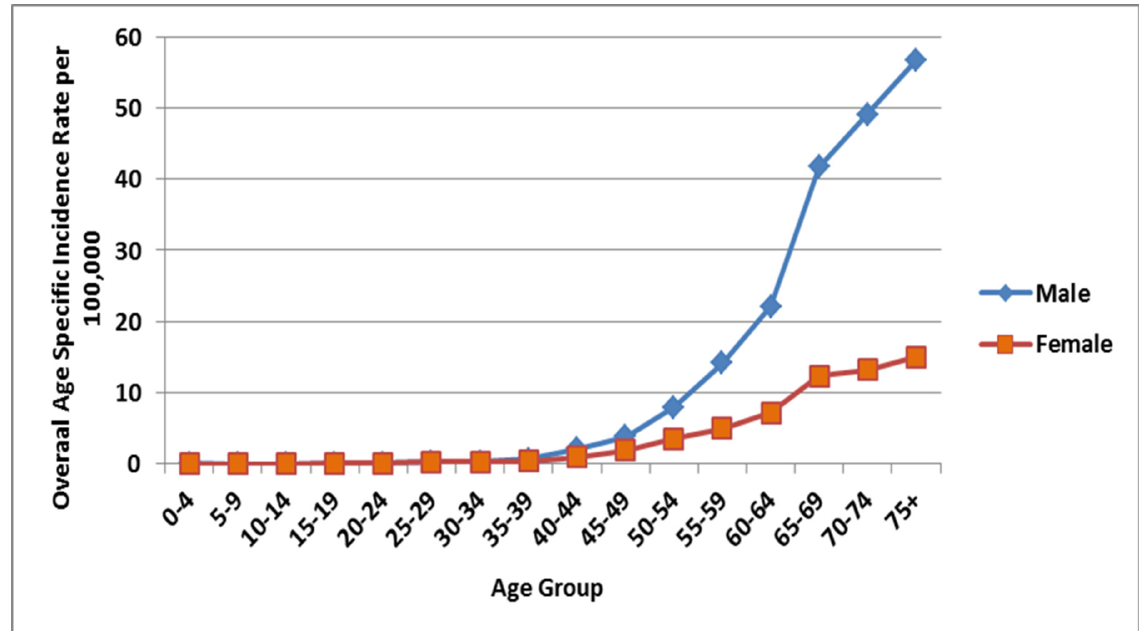
Figure 3. Overall age specific incidence rate of lung cancer cases from 2006 to 2016 per 100,000 among male and female.